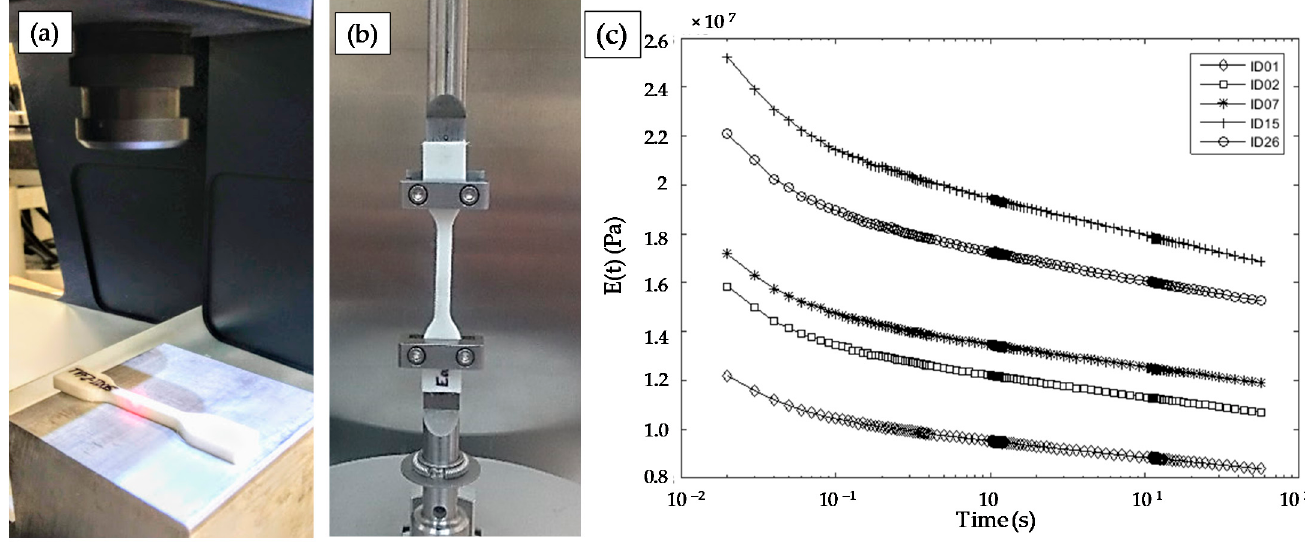
Figure 4. ( a ) Test specimen measuring using the conoscopic equipment; ( b ) mechanical testing of the specimen on the RSA3 equipment; ( c ) relaxation curves obtained during pretest work for different samples.